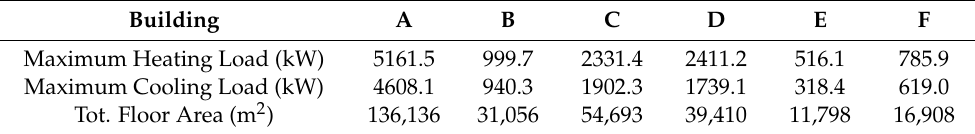
Table 4. Maximum heating and cooling loads for each